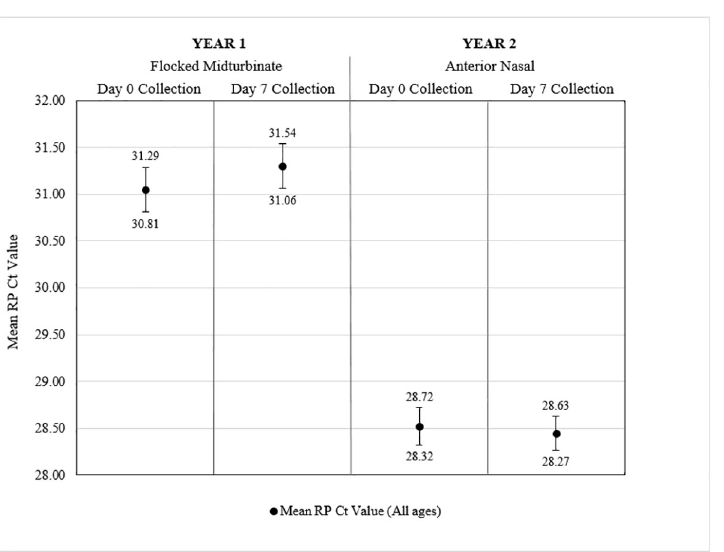
Fig 7. Mean RP Ct values of participant-collected respiratory specimens on Day 0 and Day 7 of the Household Study. Bars present the 95% confidence intervals for the mean human ribonuclease P (RP) cycle threshold (Ct) values of (from left to right) participant-collected midturbinate specimens from participants of all ages in Year 1 on Day 0, participant-collected midturbinate specimens from participants of all ages in Year 1 on Day 7, participant-collected anterior nasal specimens from participants of all ages in Year 2 on Day 0, and participant-collected anterior nasal specimens from participants of all ages in Year 2 on Day 7.